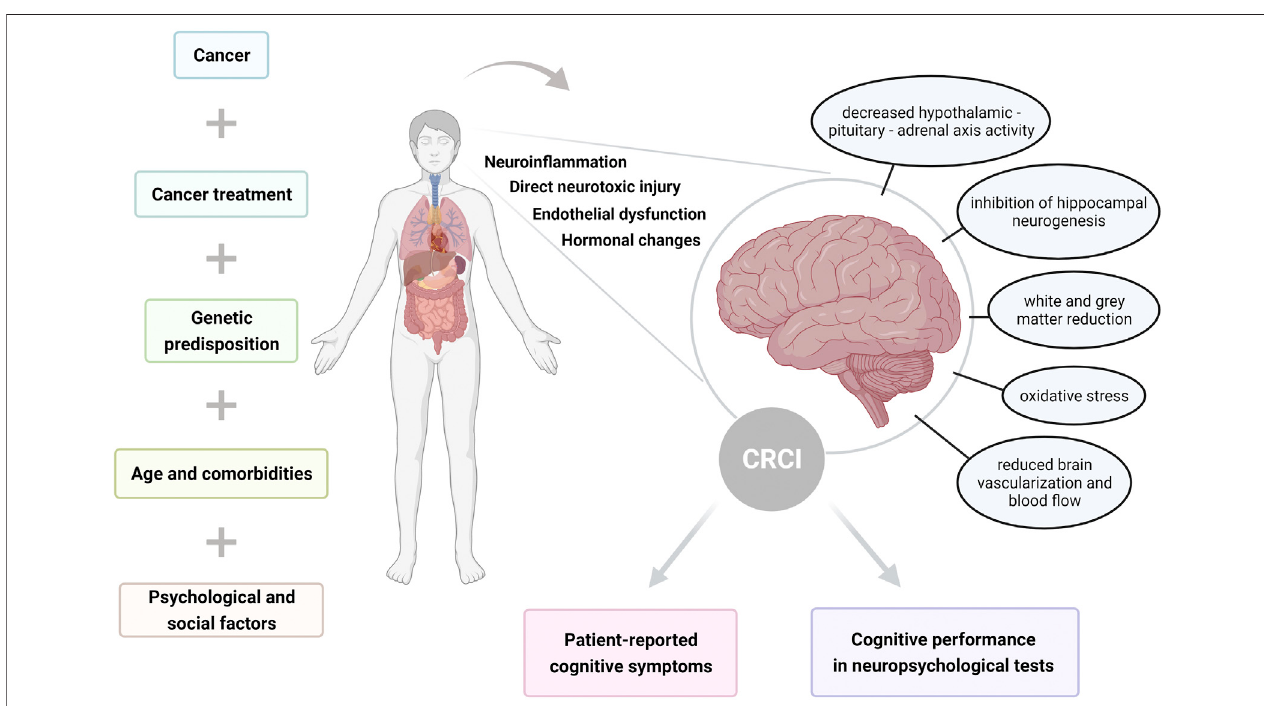
FIGURE1| Illustrationsummarizingriskfactorsandmechanismsofcancer-relatedcognitiveimpairment(CRCI),resultinginself-reportedandobjectivelyassessed cognitive dysfunction.